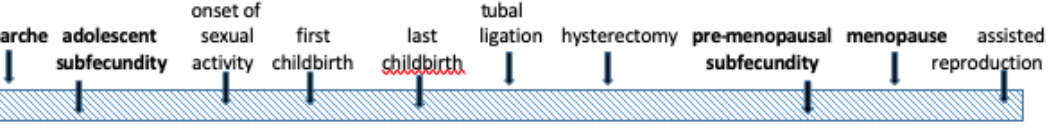
Figure 1: The temporal order of biological, behavioral, and medical events that may occur during the reproductive period and are potentiall y associated with the “biological